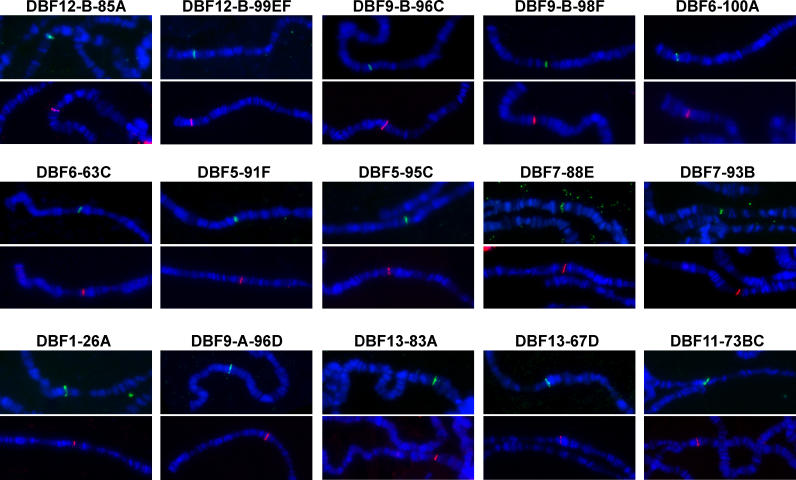
Recruitment of the DCC to DBF Insertions in Wild-Type MalesPolytene chromosomes with FISH signals in green and anti-MSL1 signals in red showing examples of DBF insertions recruiting the DCC in wild-type males. The cytological position of DBF inserts was estimated from FISH experiments (upper image in each panel). Recruitment of the DCC was demonstrated with immunoflourescence using anti-MSL1 antibodies (lower image in each panel). Examples from all DBF inserts that showed recruitment in wild-type males are shown. A summary of the complete analysis can be found in Table 2.